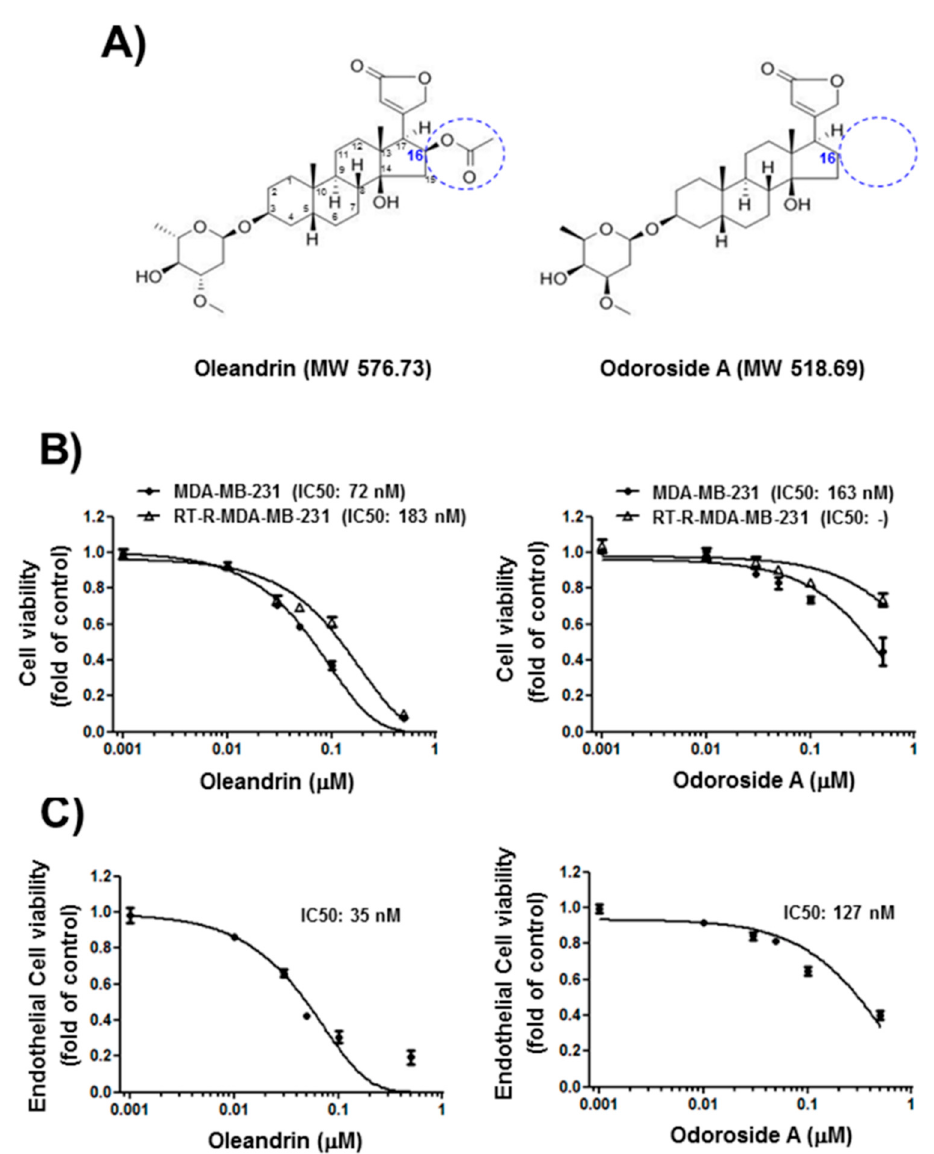
Figure 1. Chemical structure of oleandrin and odoroside A ( A ) and their effects on cell viability in MDA-MB-231 or RT-R-MDA-MB-231 cells ( B ) and ECs ( C ). ( B , C ) Cells were starved overnight and then treated with oleandrin and odoroside A at the indicated concentrations (1, 10, 30, 50, 100, and 500 nM). After 24 h, cell viability was determined by 3-(4,5-dimethylthiazol-2-yl)-2,5-diphenyltetrazolium bromide (MTT) assay. The values are expressed as the means ± SEM from three independent determinations. Blue circle in panel A shows the difference in structure between oleandrin and odoroside A.